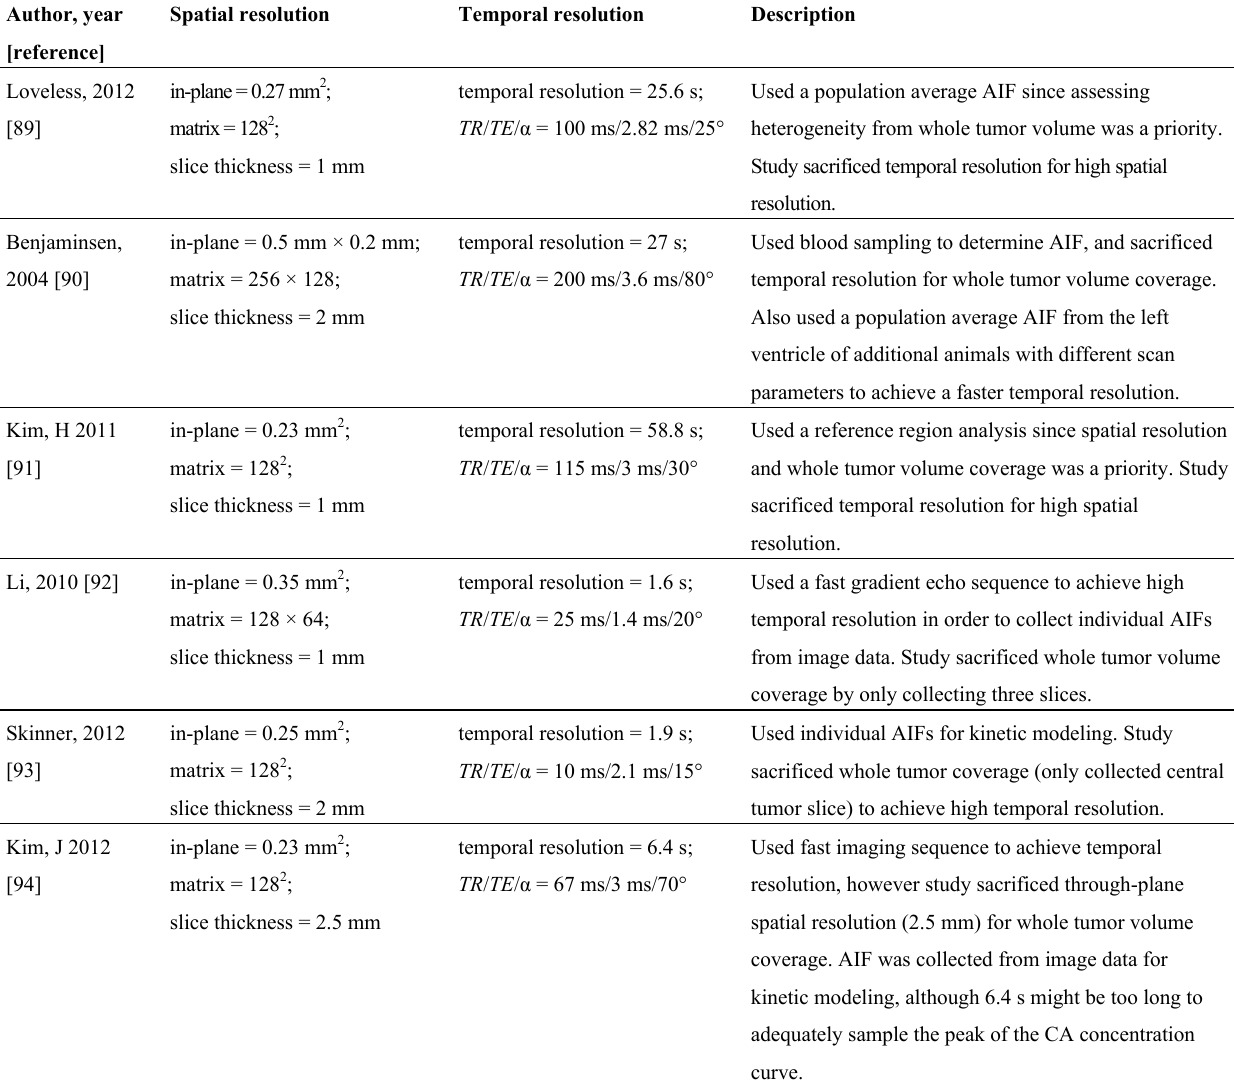
Table 1. Sequence parameters for studies designed to obtain either high spatial resolution or high temporal